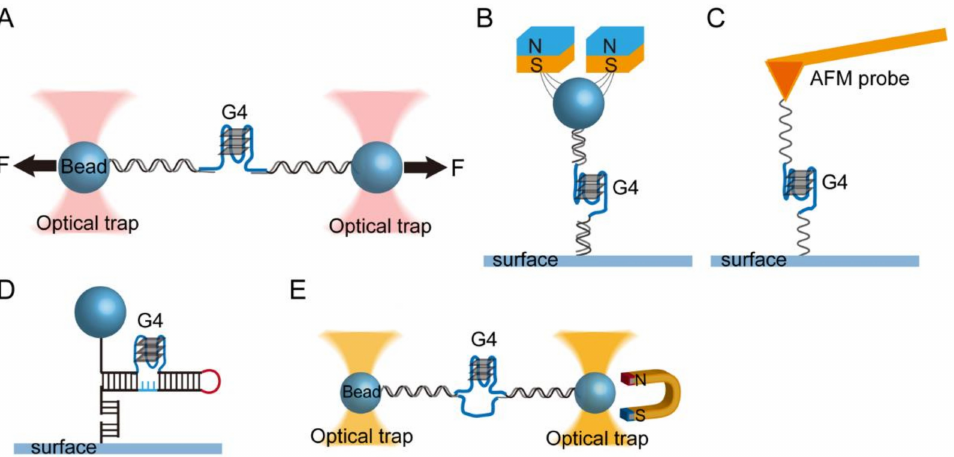
Figure 2. ( A – C ) Schematics of single-molecule force spectroscopy assays. Optical tweezers (OT) ( A ), magnetic tweezers (MT) ( B ), and atomic force spectroscopy (AFM) ( C ). A single-stranded G4-forming DNA or RNA sequence (blue) is tethered by dsDNA ( A , B ) or ssDNA ( C ) handles (black). (Adapted with permission from [50], American Chemical Society; [61], Oxford Academic; [87], American Chemical Society). ( D , E ) G4s embedded in double-stranded DNA studied by MT ( D ) and magneto-optical tweezers ( E ). (Adapted with permission from [90], Oxford Academic; [88], American Chemical